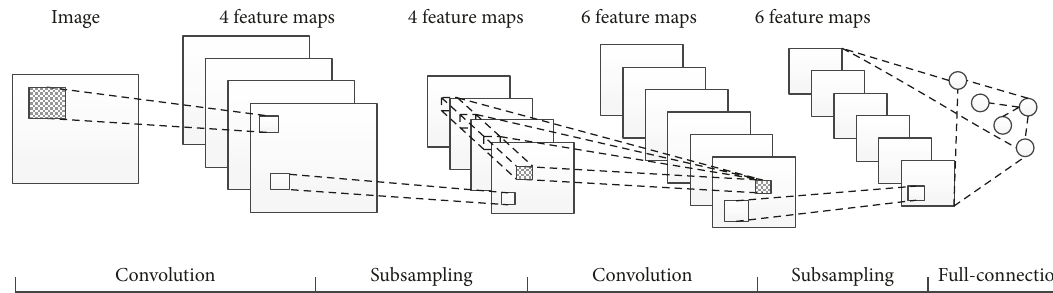
Figure 2: A common CNN